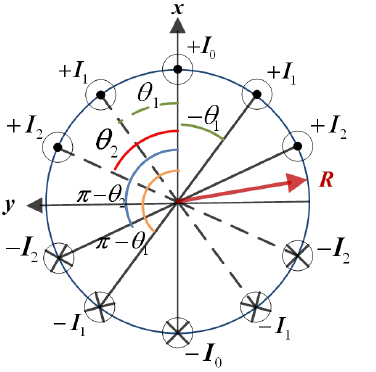
Figure 2. Electrical conductors of unknown angular positions ( θ n ), flown by currents I n , distributed along the circumference.